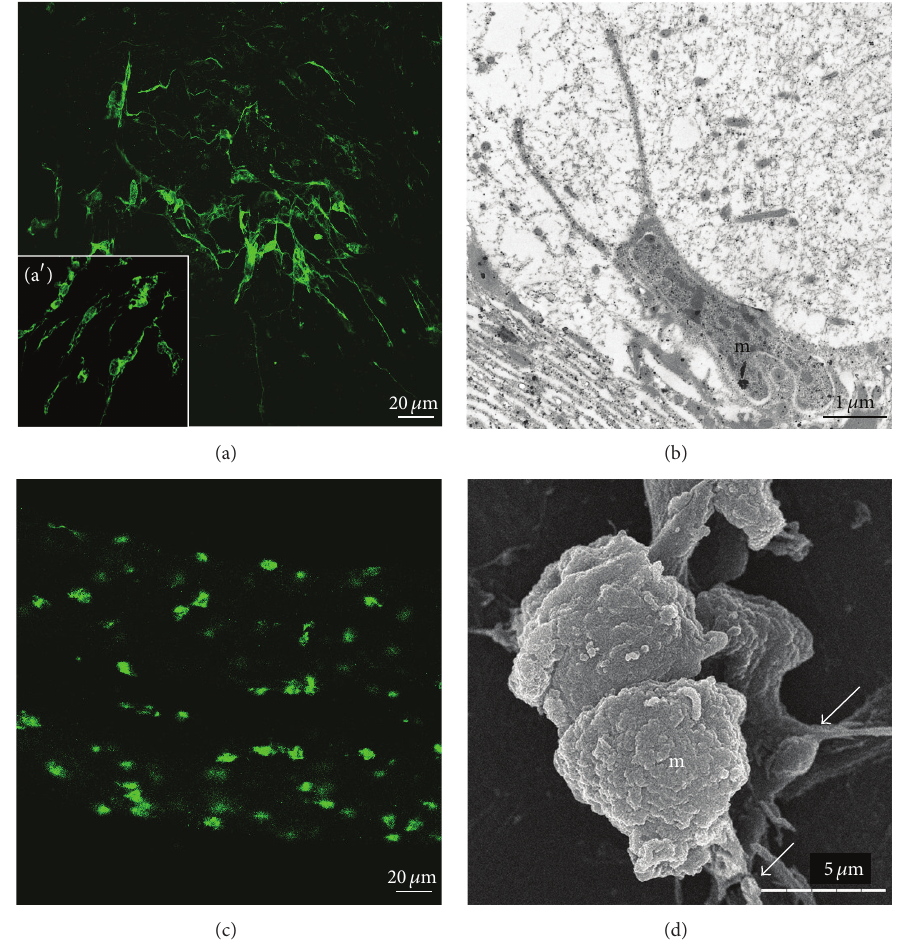
Figure 4: Transformation of resident microglia (m) into activated cells allowing their migration to the injury site. (a) and (c) Immunohistochemical staining using anti-gliarin antibody in ramified microglial cells from connectives (a), ramified microglial cells from ganglia (a 󸀠 ), and rounded microglial cells during their recruitment in connectives (c). (b) Transmission electron microscopy of an elongated microglial cell (m) with thin pseudopods in a naive ganglion. (d) Scanning electron microscopy of activated microglial cells accumulated at the lesions. Once recruited, the cells do progressively develop new ramifications (arrows). (Reprinted, with permission, from